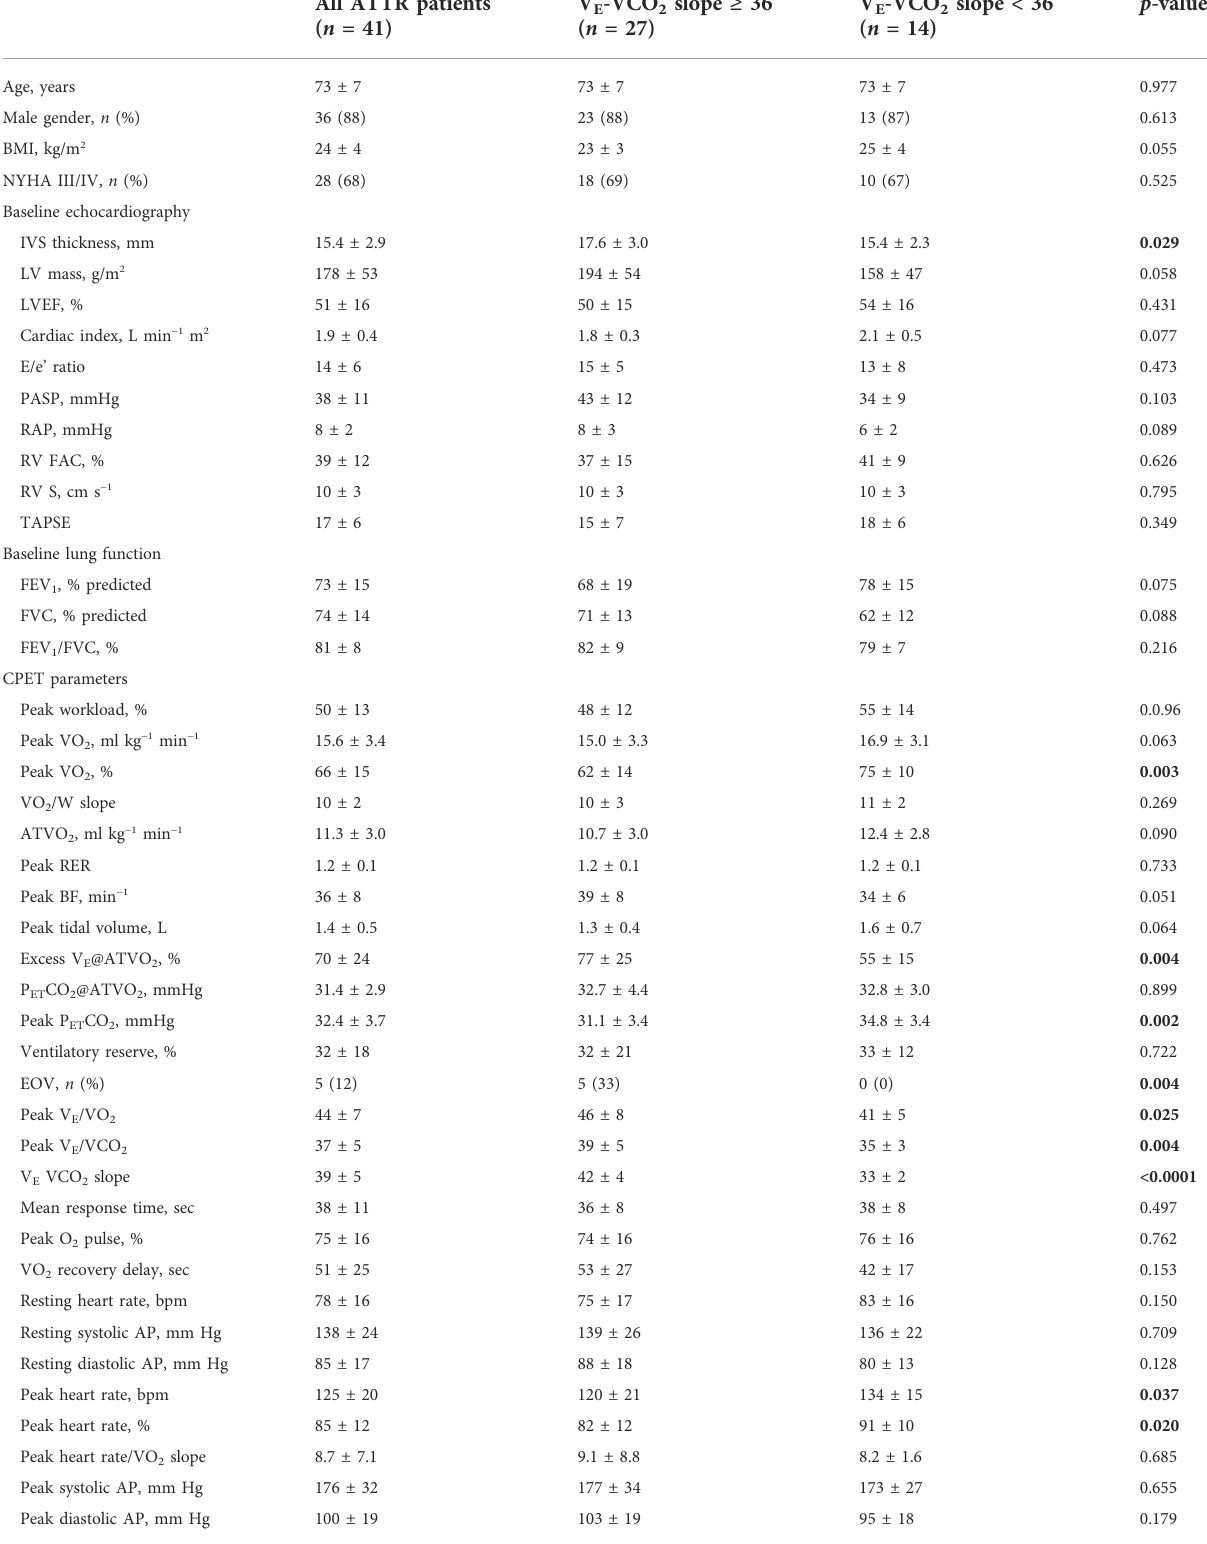
TABLE 1 Main characteristics of cardiac ATTR amyloidosis patients according to ventilatory inef fi ciency V E -VCO 2 slope. All ATTR patients ( n =